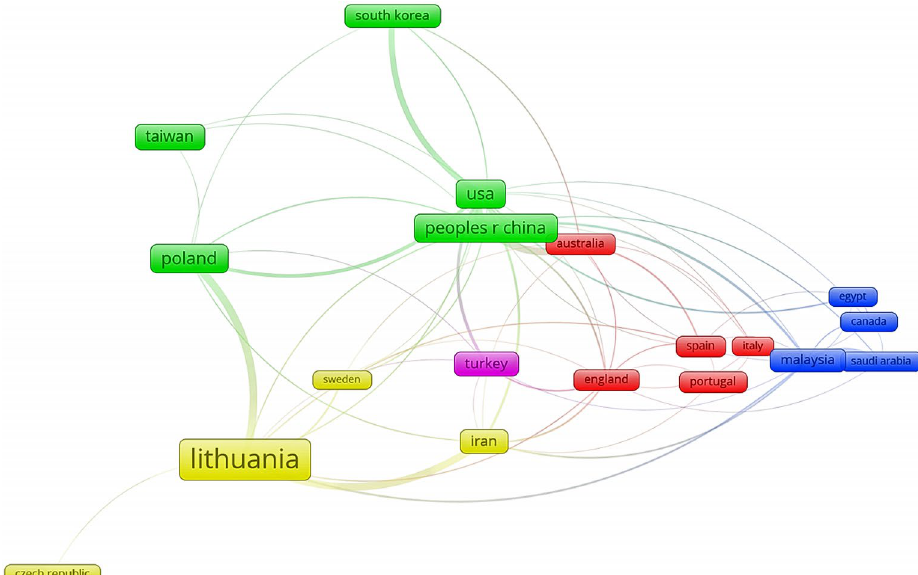
Figure 1. Cooperation networks at the country/territory level